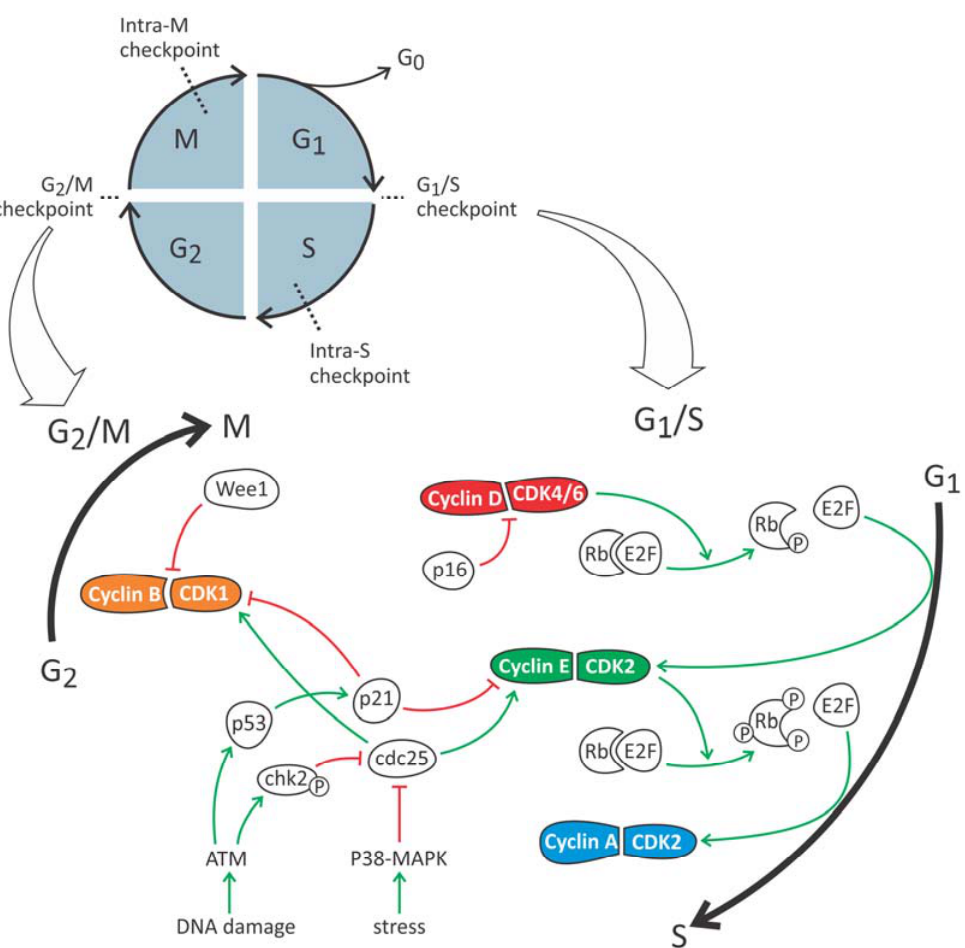
Figure 2. Pathways involved in cell cycle progression and arrest during G1/S and G2/M transition.